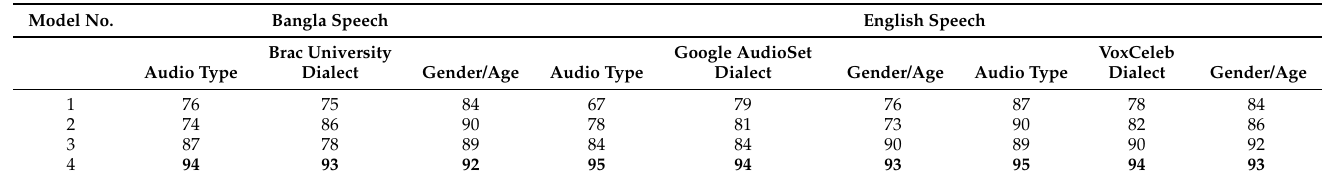
Table 8. Classification Accuracy (%) of the four different SCAE-MLELMs’ architecture on different datasets with input format as MFCCs ; Brac University previous and self-built Bangla Speech dataset and Google Audio-Set and VoxCeleb for English speech dataset were used during the experiment. Numbers in bold represent the highest classification accuracies.